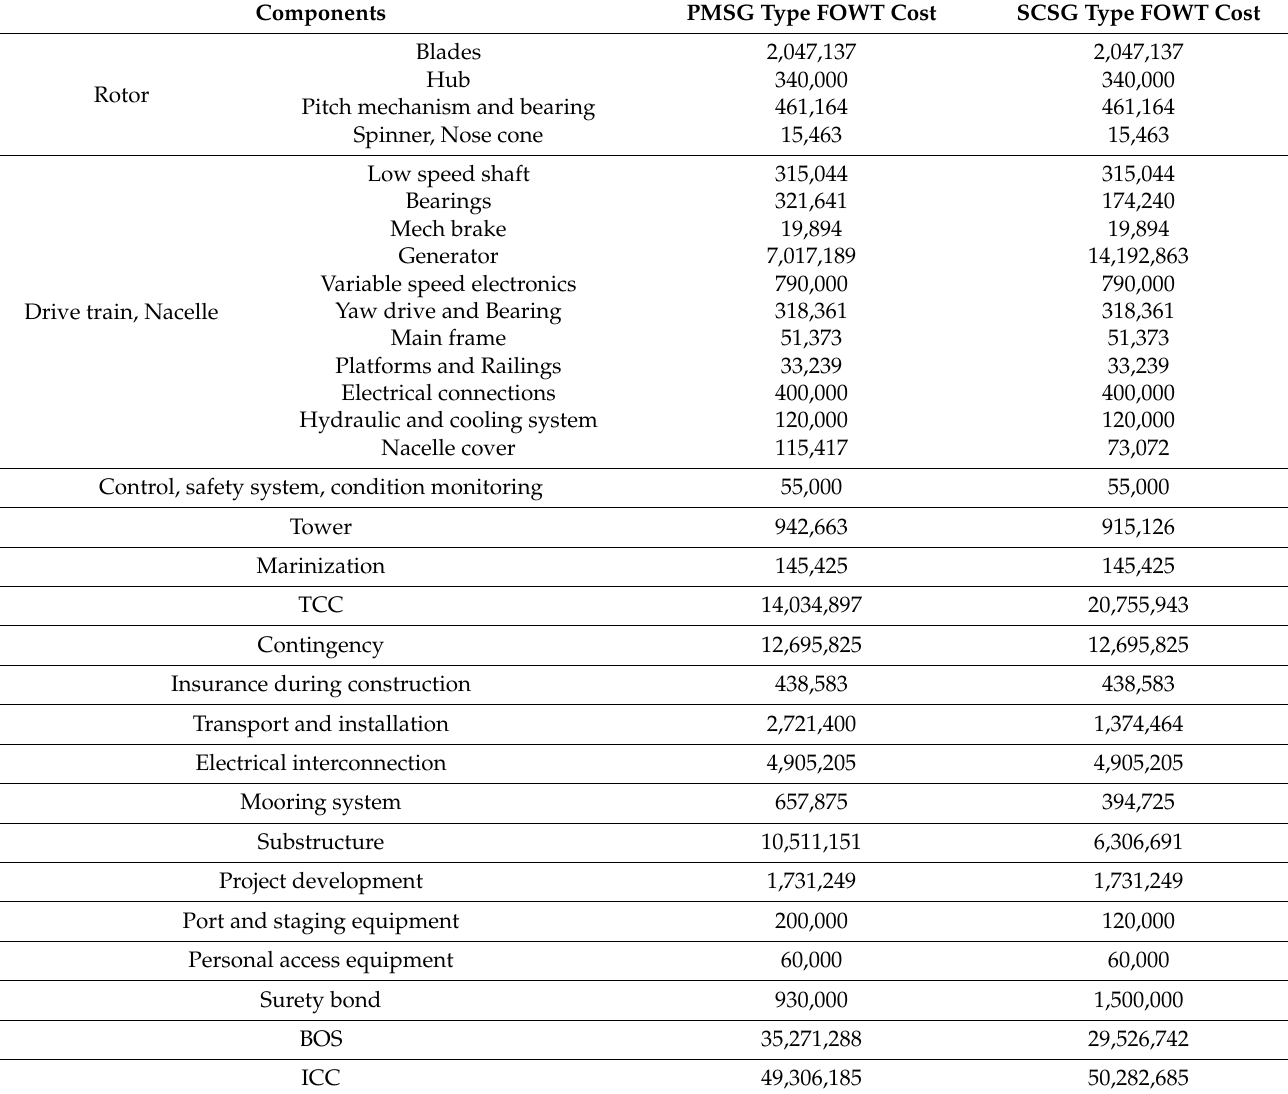
Table 10. The capital expenditure (CAPEX) of the 10 MW class PMSG and SCSG types FOWTs (unit: